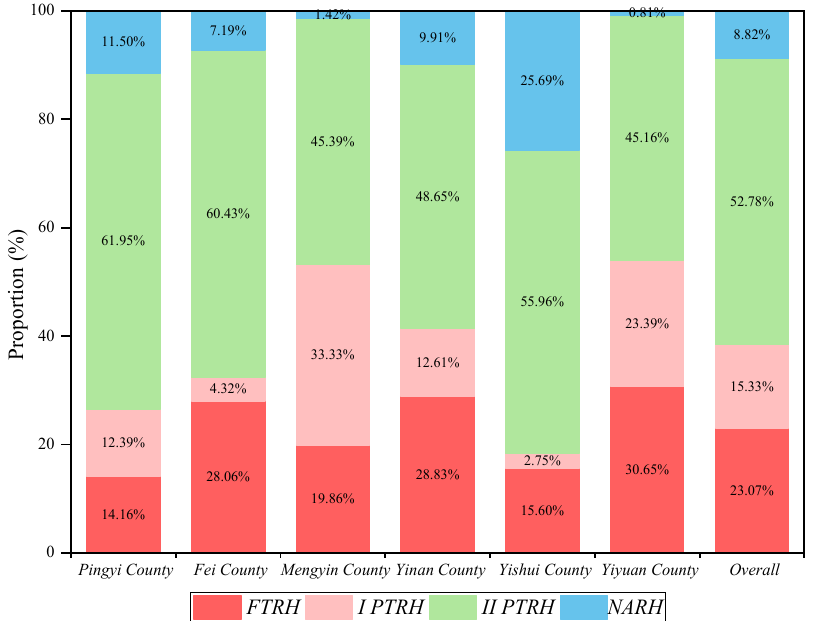
Figure 2. Classification of rural household types. Table 4. Inputs of different types of rural